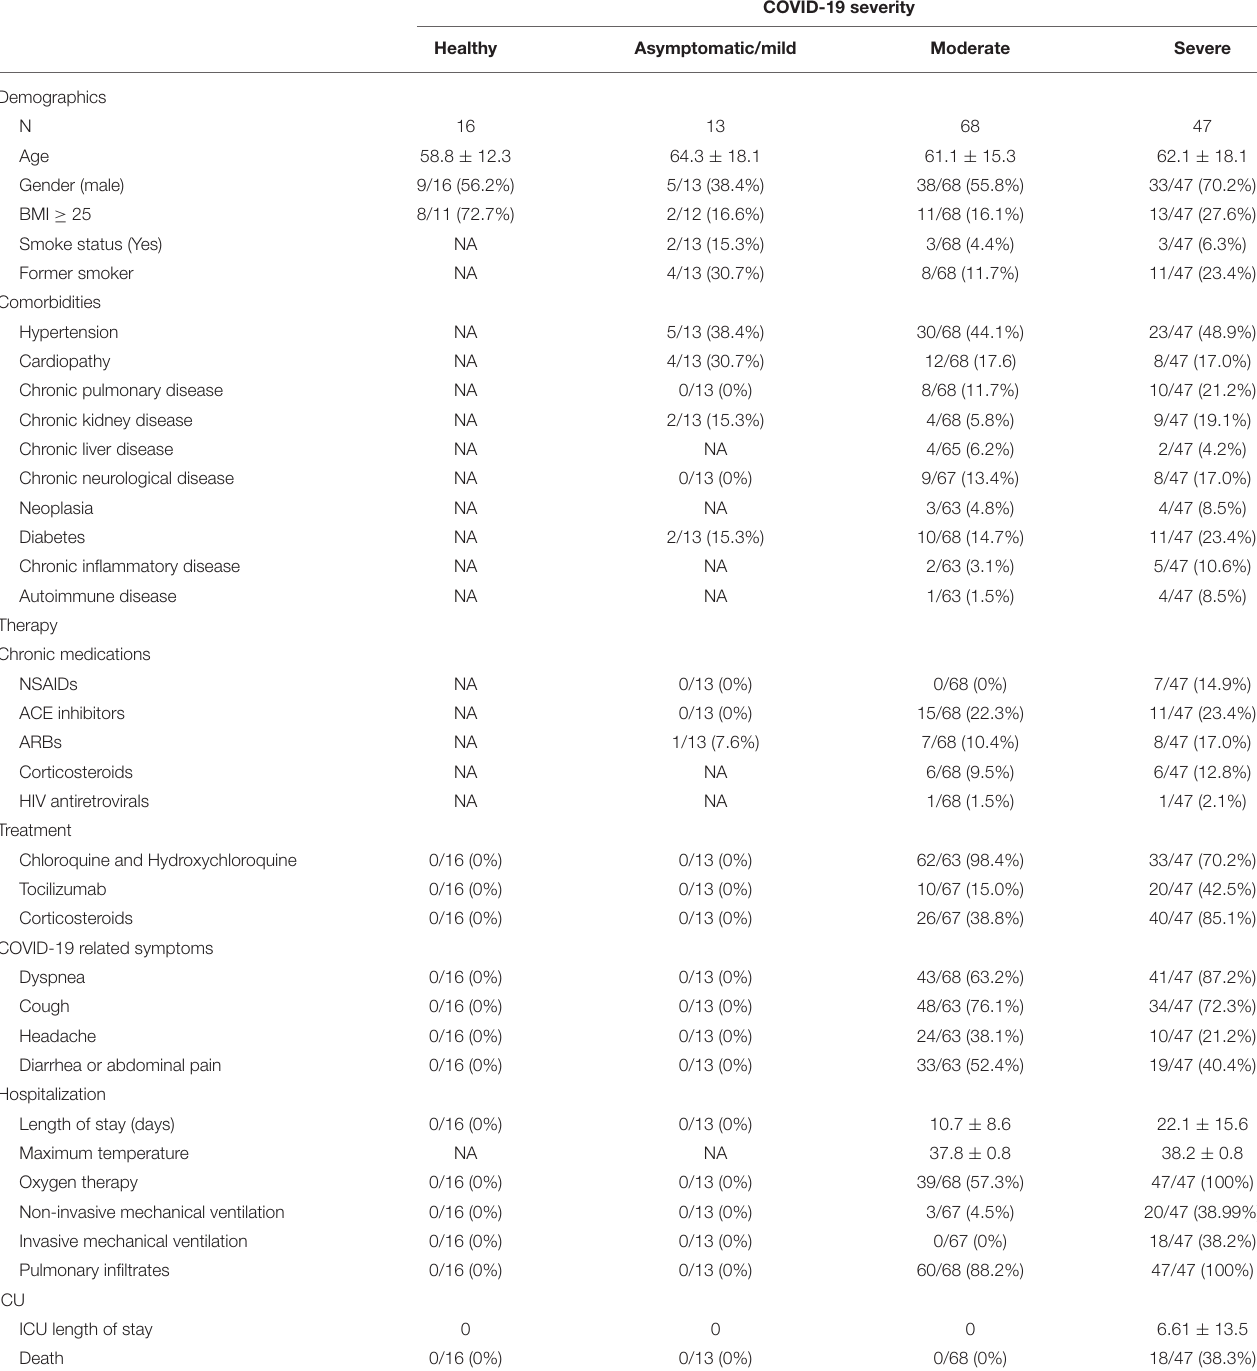
TABLE 1 | Patient’s